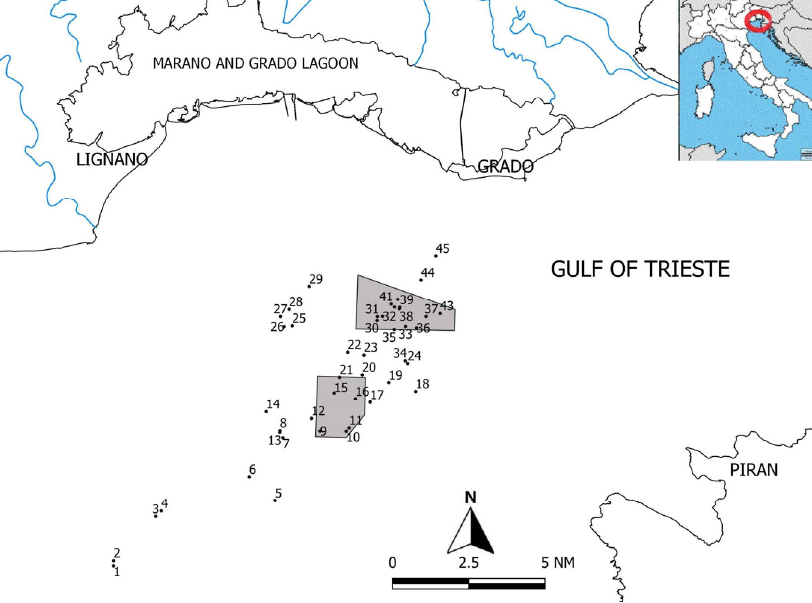
Figure 1. Study area with outcrops investigated and Sites of Community Importance (in grey). Table 1. Names of the 45 rocky outcrops investigated by SCUBA diving, sampling depth, distance from the coasts, and number of invertebrates’ taxa. * = outcrops in which a 30 × 30 cm square was investigated to compare the expected richness from SAR model; SCI indicates the outcrop inside the sites of community importance.